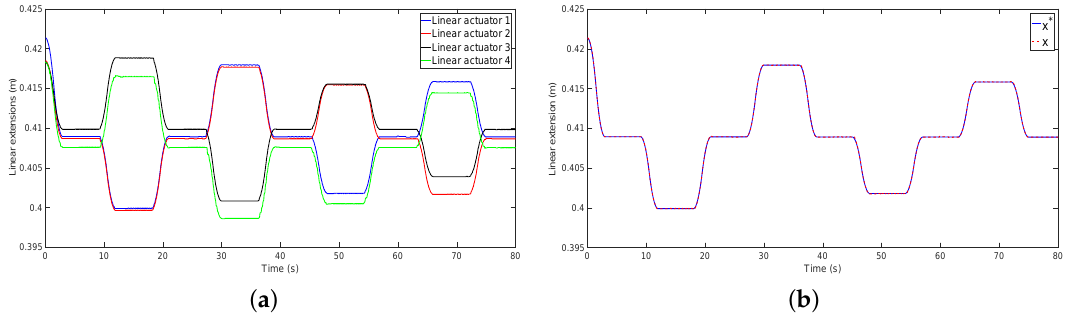
Figure 22. ( a ) extension of the linear actuators; ( b ) extension of a linear actuator using Equation (32). The maximum errors of the system between the references and the outputs are E h = 0.2 ◦ and E φ = 0.2 ◦ E θ ∗ ∗